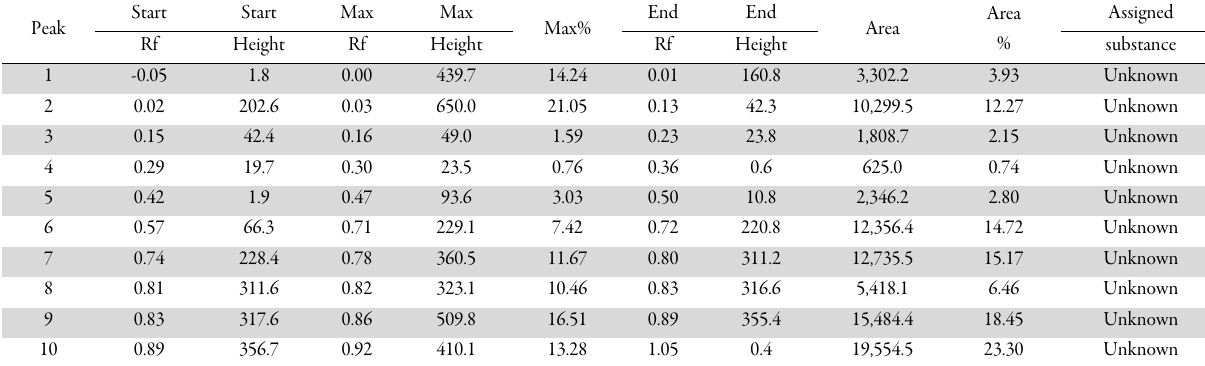
Table 6. HPTLC analysis of soxhalated ethyl acetate fruit extract Peak